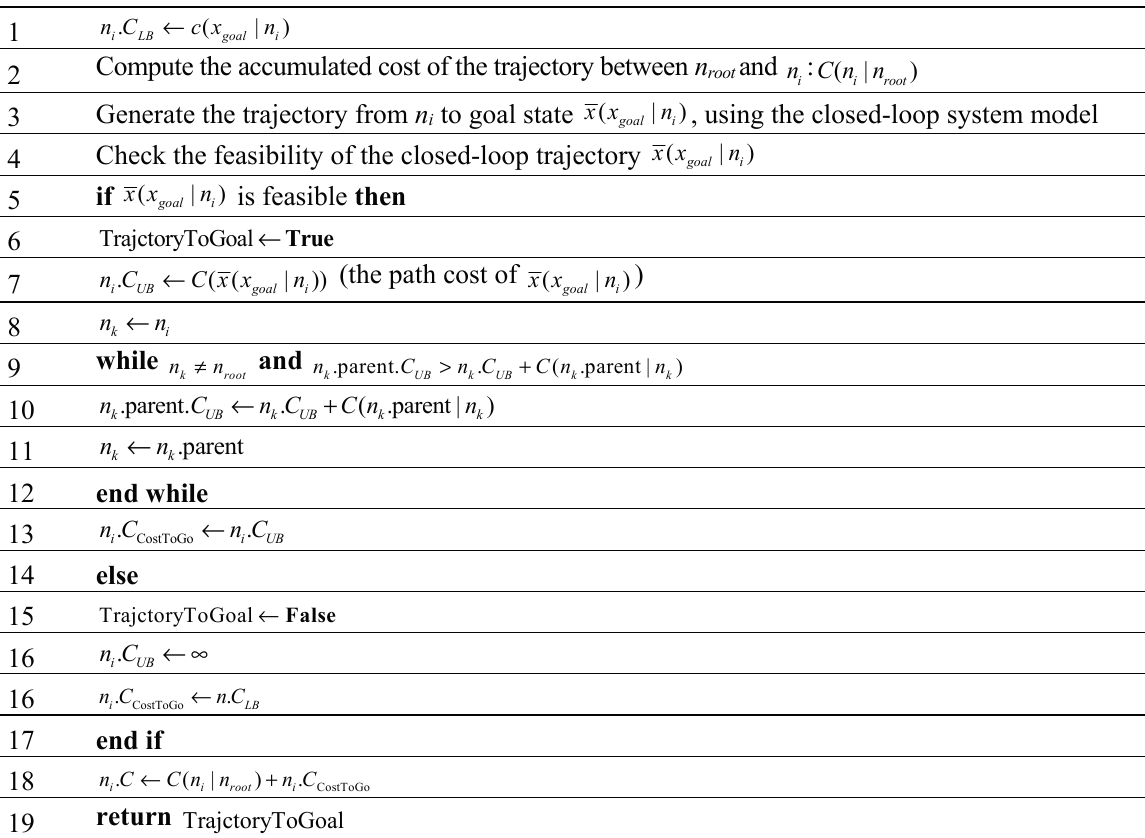
Algorithm 2. Closed-loop random belief tree: cost